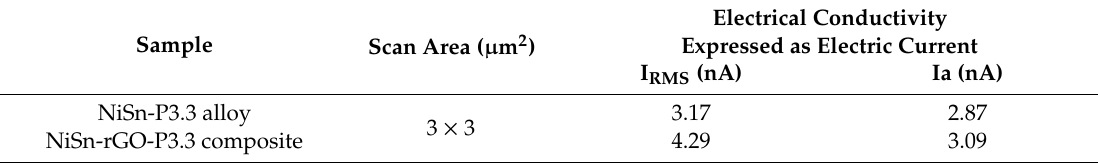
Table 5. Electrical conductivity values for the specimens from Figure 14.